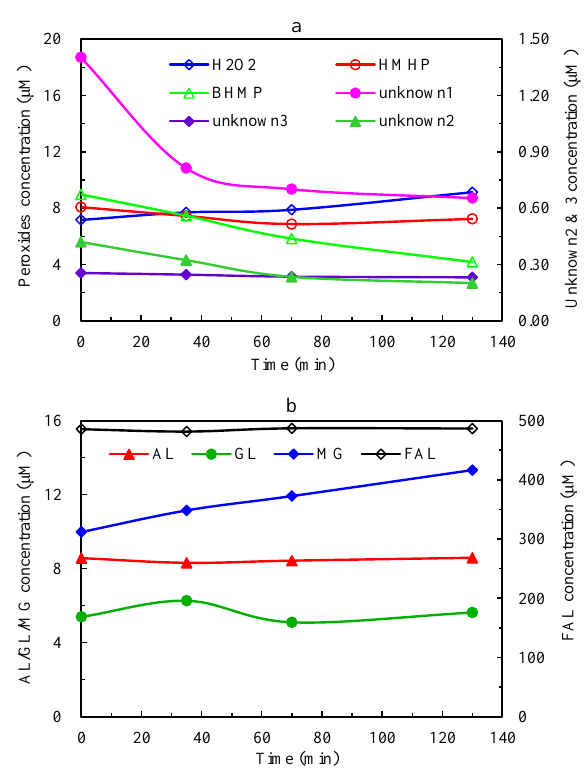
Fig. 6. Temporal profiles of (a) peroxides and (b) carbonyls of a sample collected with H 3 PO 4 solution and stored at room temper- ature ( ∼ 25 ◦ C). AL: acetaldehyde; GL: glyoxal; MG: methyl gly- oxal; FAL: